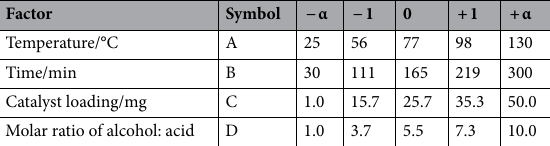
Table 4. Ranges and levels of the experimental parameters.